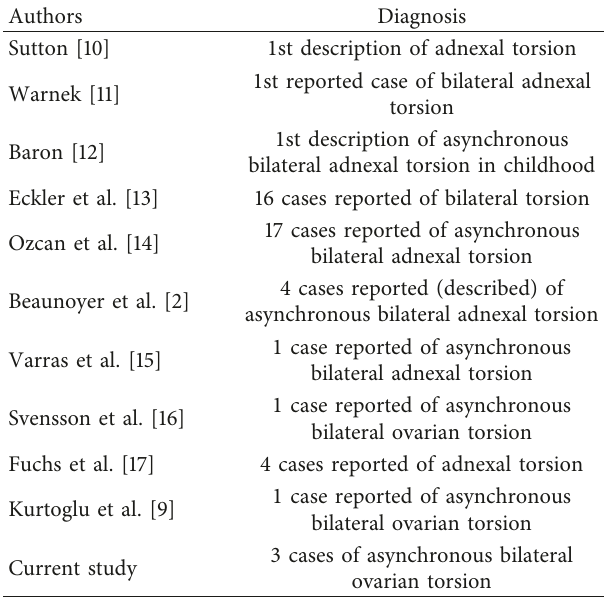
Table 1: The reported cases of ABOT in the